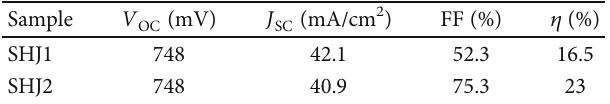
Figure 6: I-V characteristics under illumination for SHJ1 and SHJ2 under thermionic emission transport conditions and with a fl atband TCO interface. Table 3: Device I-V parameters extracted for cells SHJ1 and SHJ2 under illumination with the thermionic emission